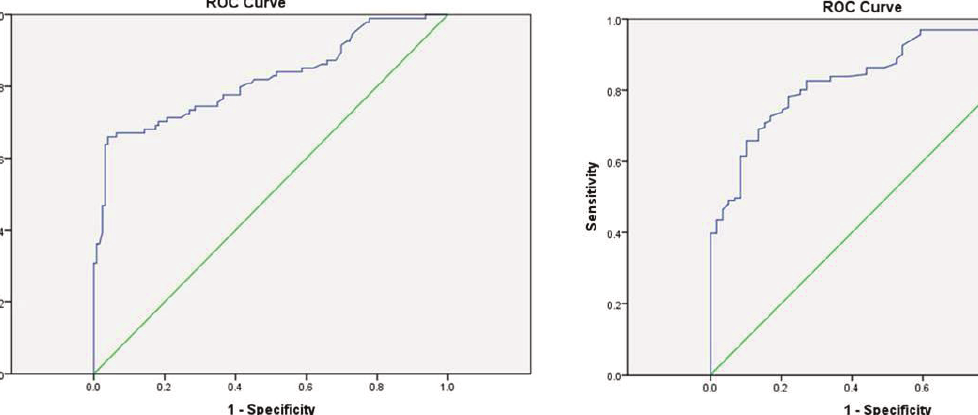
Figure 1: Diagnosis of HE4 boundary values with ovarian benign tumor, ovarian non- neoplastic lesions and healthy women as for reference.